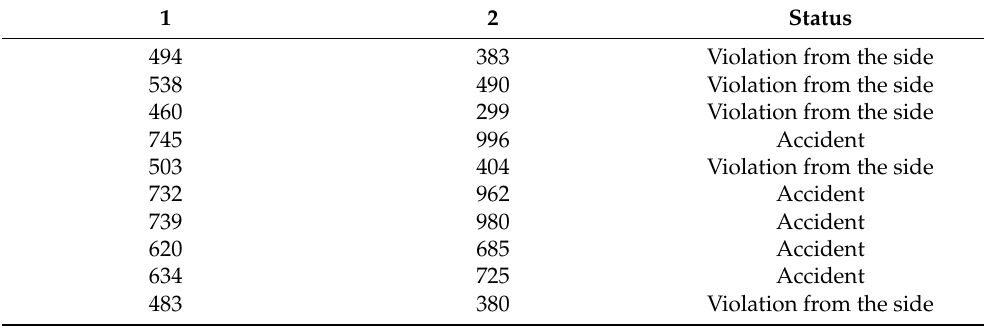
Table 5. The results of testing the position of the Z -axis peak (1) and g value (2) when an accident occurs.